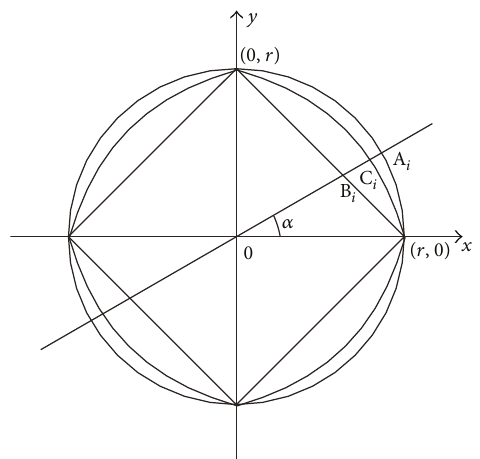
Figure 3: Shape blending calculation between a circle and a